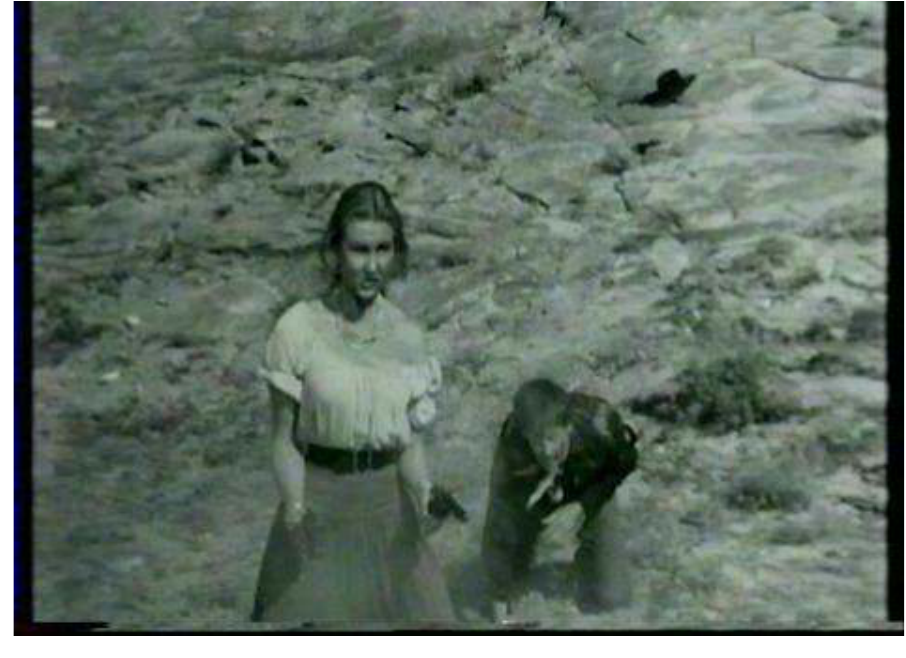
Figure 17: Colorado shooting in Colorado